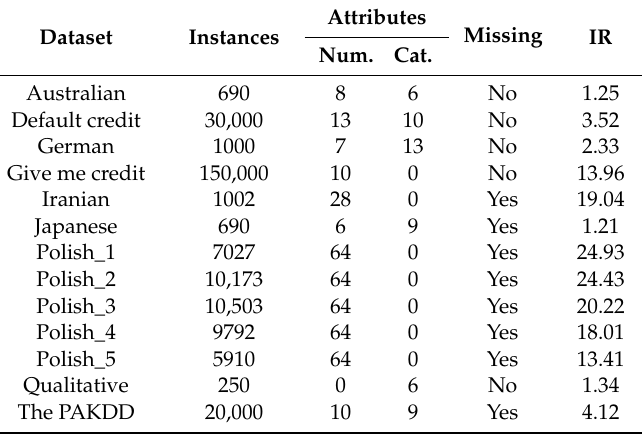
Table 1. Description of the